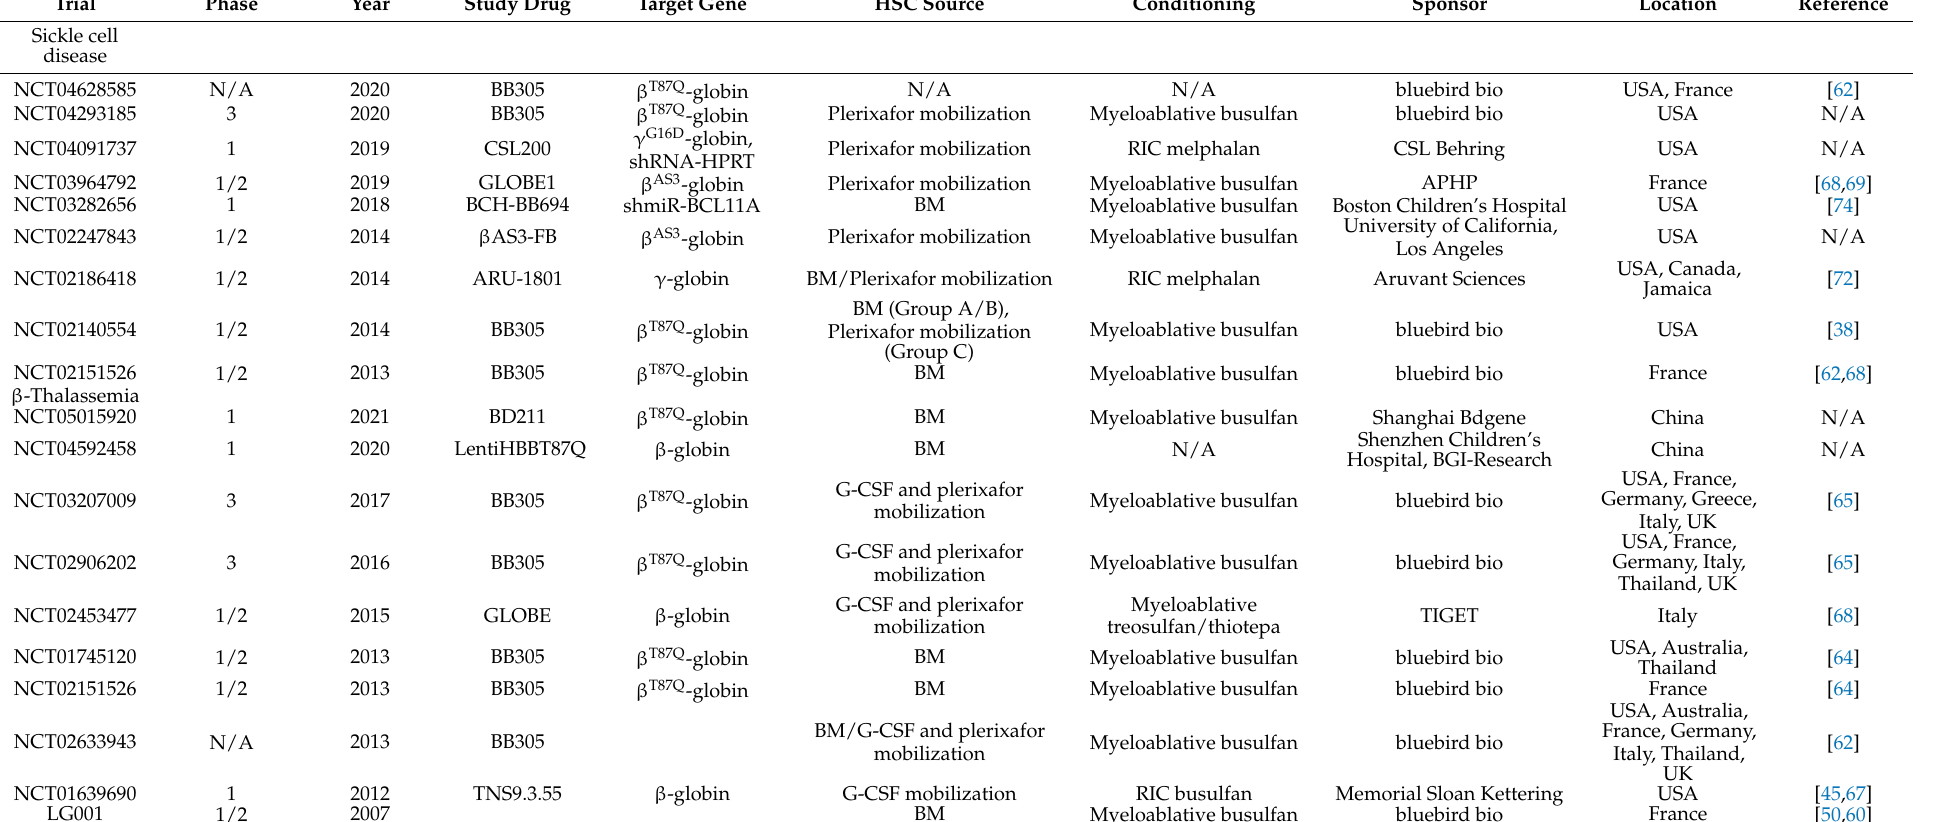
Table 1. A summary of lentiviral HSC gene-addition therapy trials in SCD and transfusion-dependent β -thalassemia